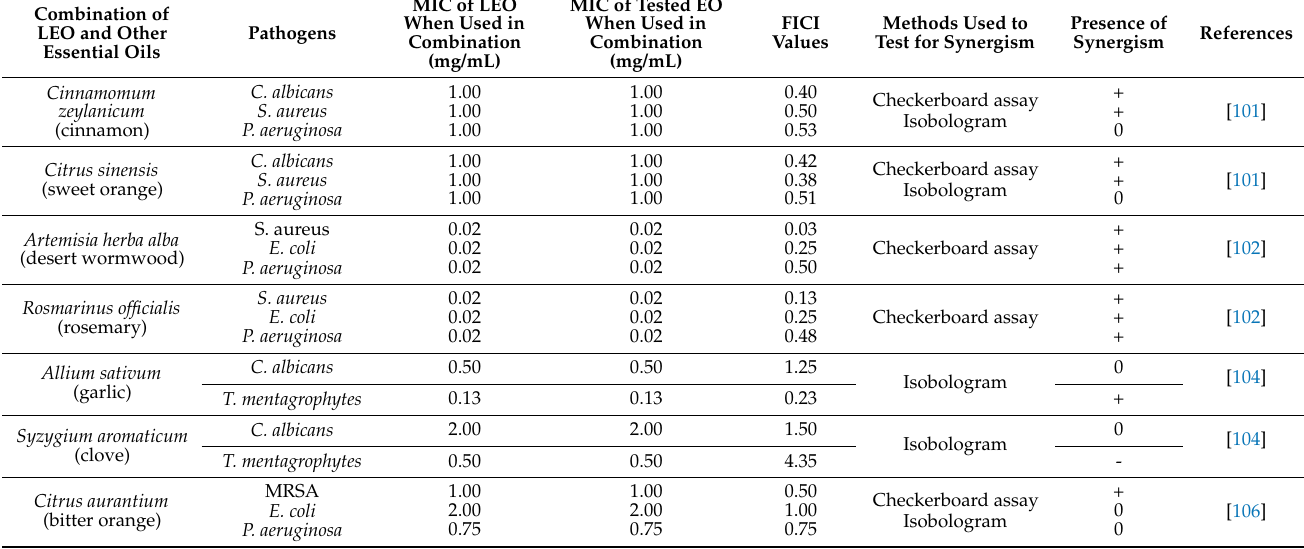
+ indicates synergy; 0 indicates additivity; - indicates antagonism; MRSA: methicillin-resistant Staphylococcus aureus